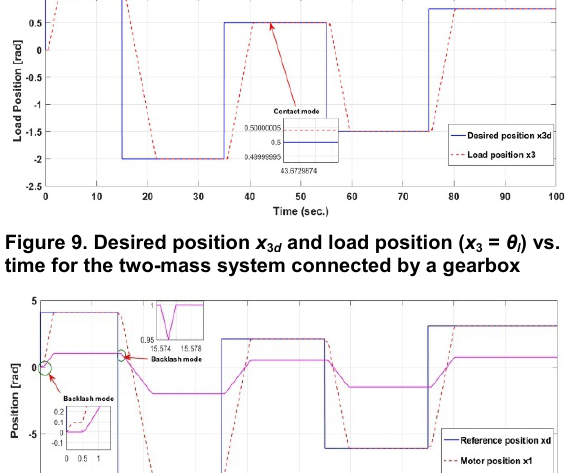
Figure 14. Control action T m ( t ) vs. time for the two-mass systems connected by a